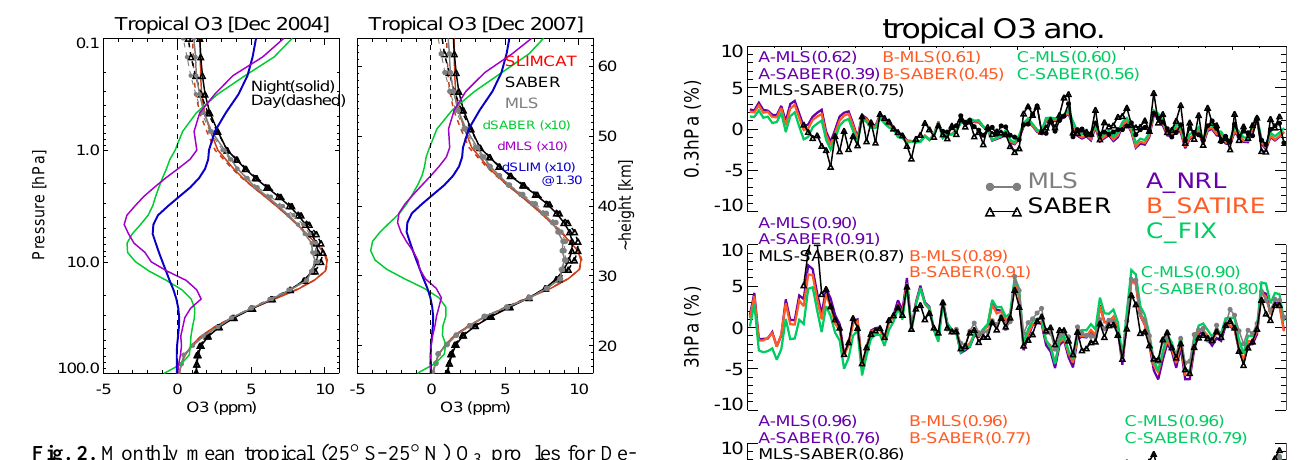
Fig. 2. Monthly mean tropical (25 ◦ S–25 ◦ N) O 3 profiles for De- cember 2004 and December 2007 from SABER data (black), MLS data (grey) and SLIMCAT run A_NRL (orange). Solid and dashed lines represent night-time and daytime profiles, respectively. Also shown is the O 3 diurnal variation (night–day) for SABER (green), MLS (violet) and SLIMCAT (light blue). The SLIMCAT differ- ences are shown for 01:30UTC and 13:30UTC. For clarity, the di- urnal variations have been multiplied by 10.